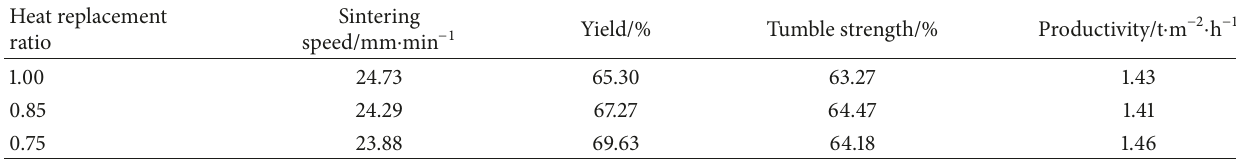
Table 5: Effect of heat replacement ratio on sintering